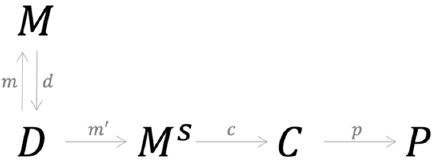
Figure 9. A category representing the equivalence trap.